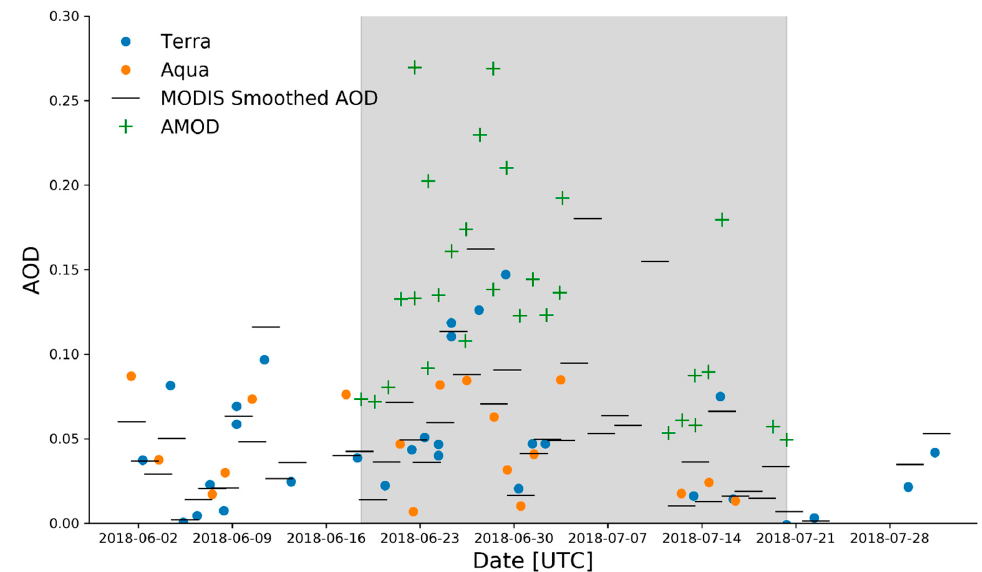
Figure 9. MODIS AOD retrieval from Terra (blue) and Aqua (orange) overpasses for Palapye (points) as well as the surrounding 100 km average (black), with AMOD AOD at 520 nm overlaid (green crosses). The shaded gray area refers to the duration of the measurement campaign.